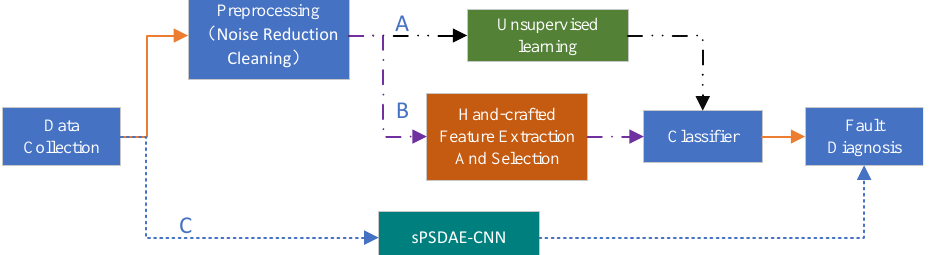
Figure 1. Three kinds of intelligent fault diagnosis framework. ( A ) The feature extraction of unsuper- vised learning [28]. ( B ) The traditional method. ( C ) The method used in this article. At present, there is much research on sensor fault and actuator fault of four-rotor UAVs. In article [29,30], it is mainly studied to diagnose the actuator fault of four-rotor UAV by using the traditional model class method, including hybrid observer and adaptive neural network observer. In [31], Kalman filter is mainly used to process the sensor data of UAV and then to diagnose the possible sensor faults. In [32], researchers proposed a disturbance observer to observe the faults in the system and then realized diagnosis and fault-tolerant control through sliding mode control